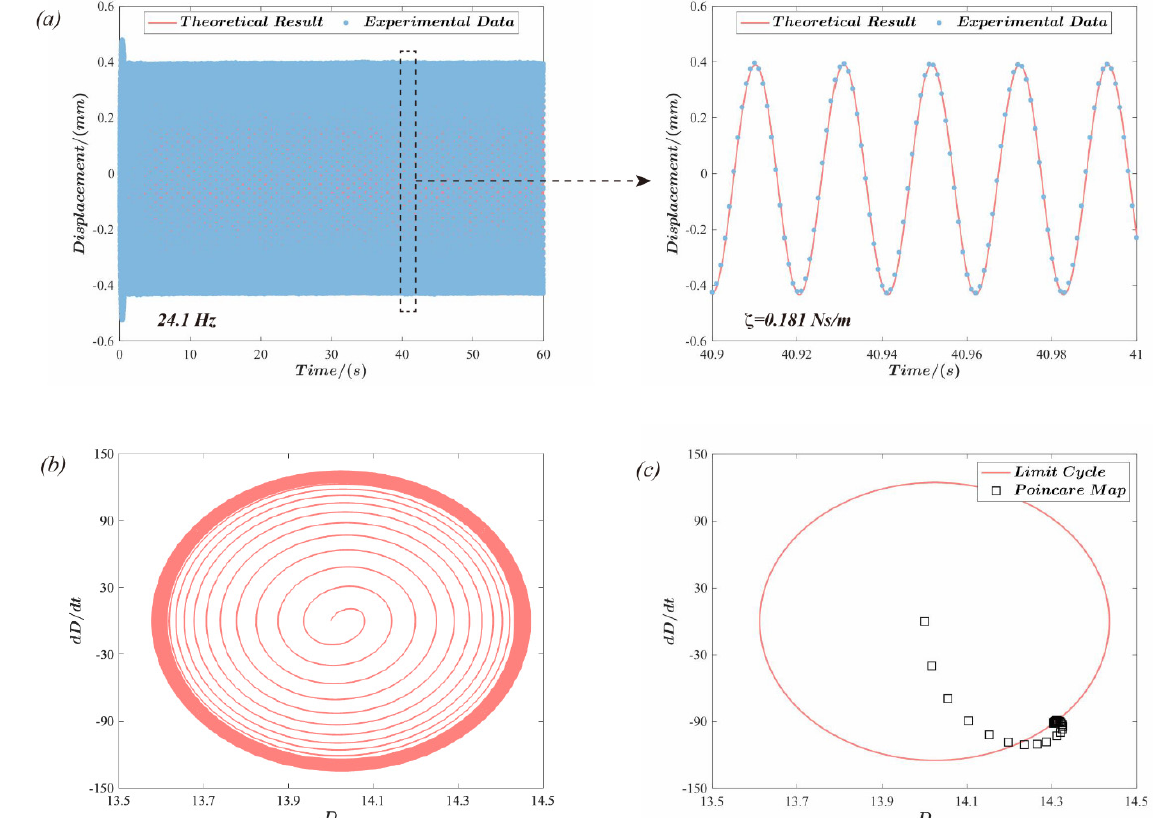
Figure 6. Dynamic actuation performance of the actuator under sinusoidal voltage excitation: ( a ) the response displacement versus time of the actuator for the excitation frequency f = 24.1 Hz and the comparison with the theoretical results; ( b , c ) provide the phase diagram, limit cycle, and Poincaré map of the push-pull DEA based on the theoretical analysis.